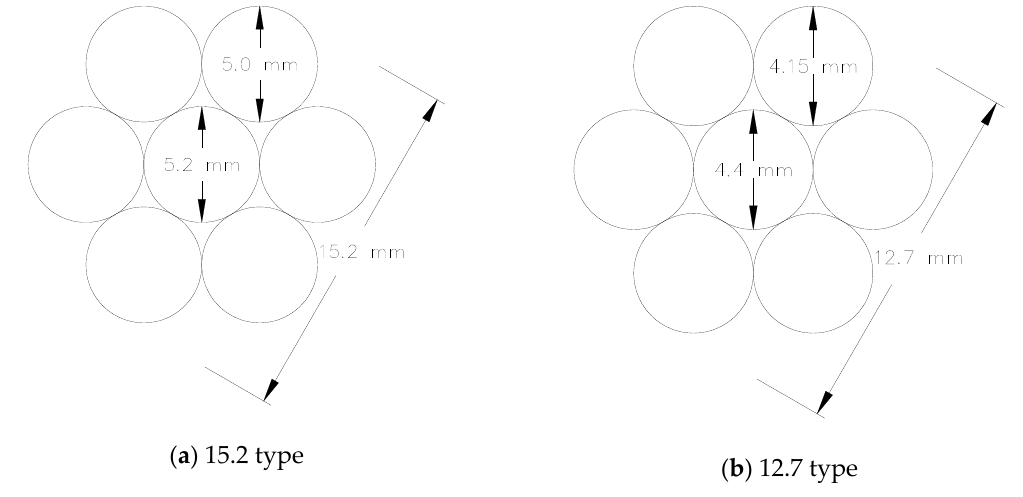
Figure 8. Section profiles of seven-wire strands.